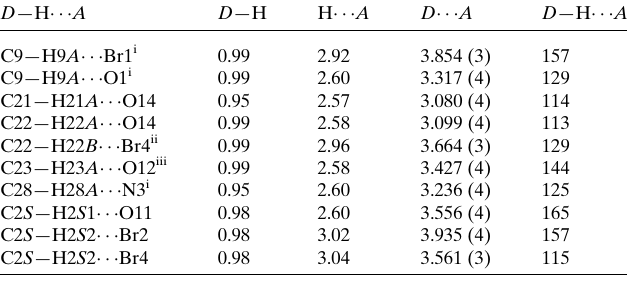
Table 1 Hydrogen-bond geometry (A˚ , (cid:3) ).